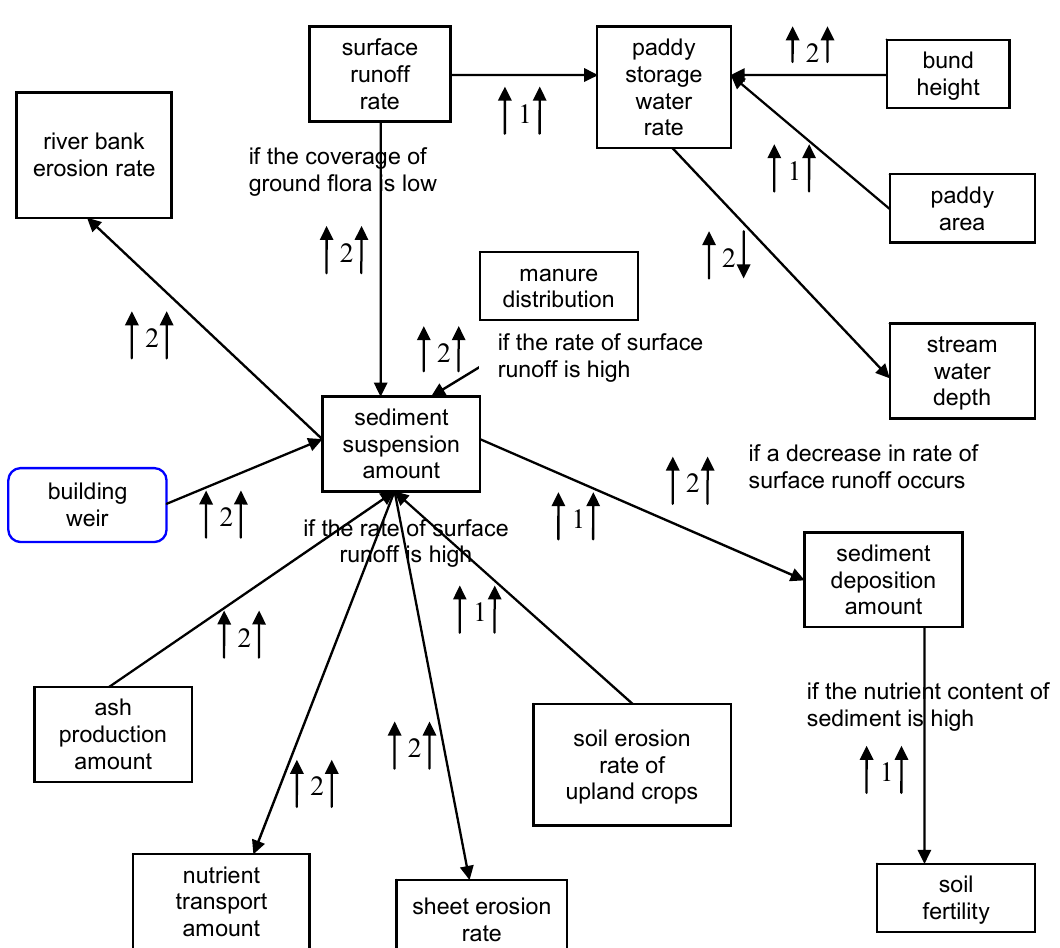
Figure 7. Local perceptions of cause-effect relationships associated with integrated paddy-field-ruminant agroecosystem. Source: Generated with AKT5, based on data from interviews and focus group